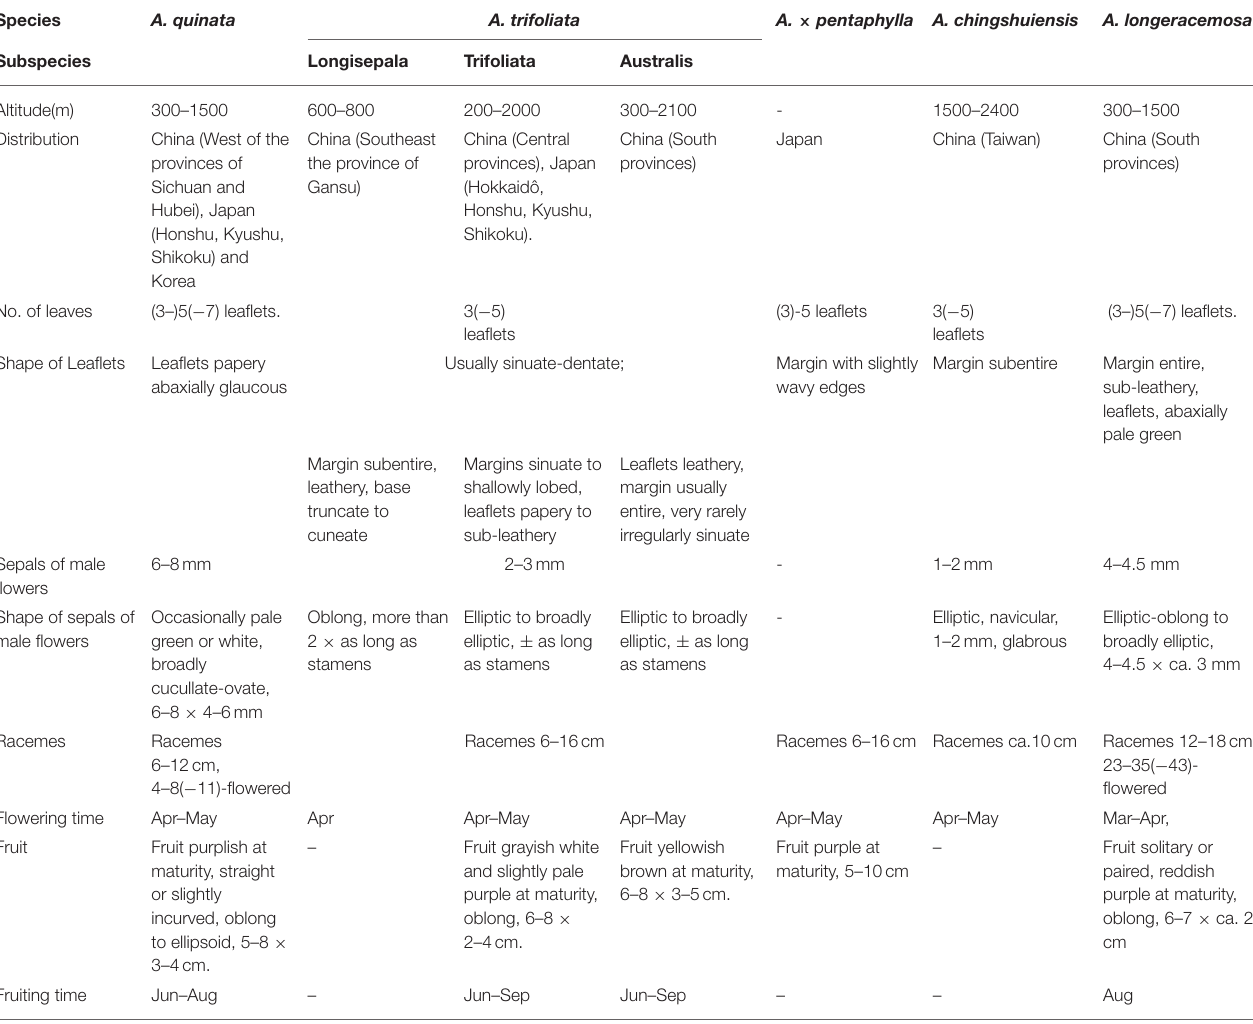
TABLE 1 | Natural distribution and botanical characteristics of Akebia